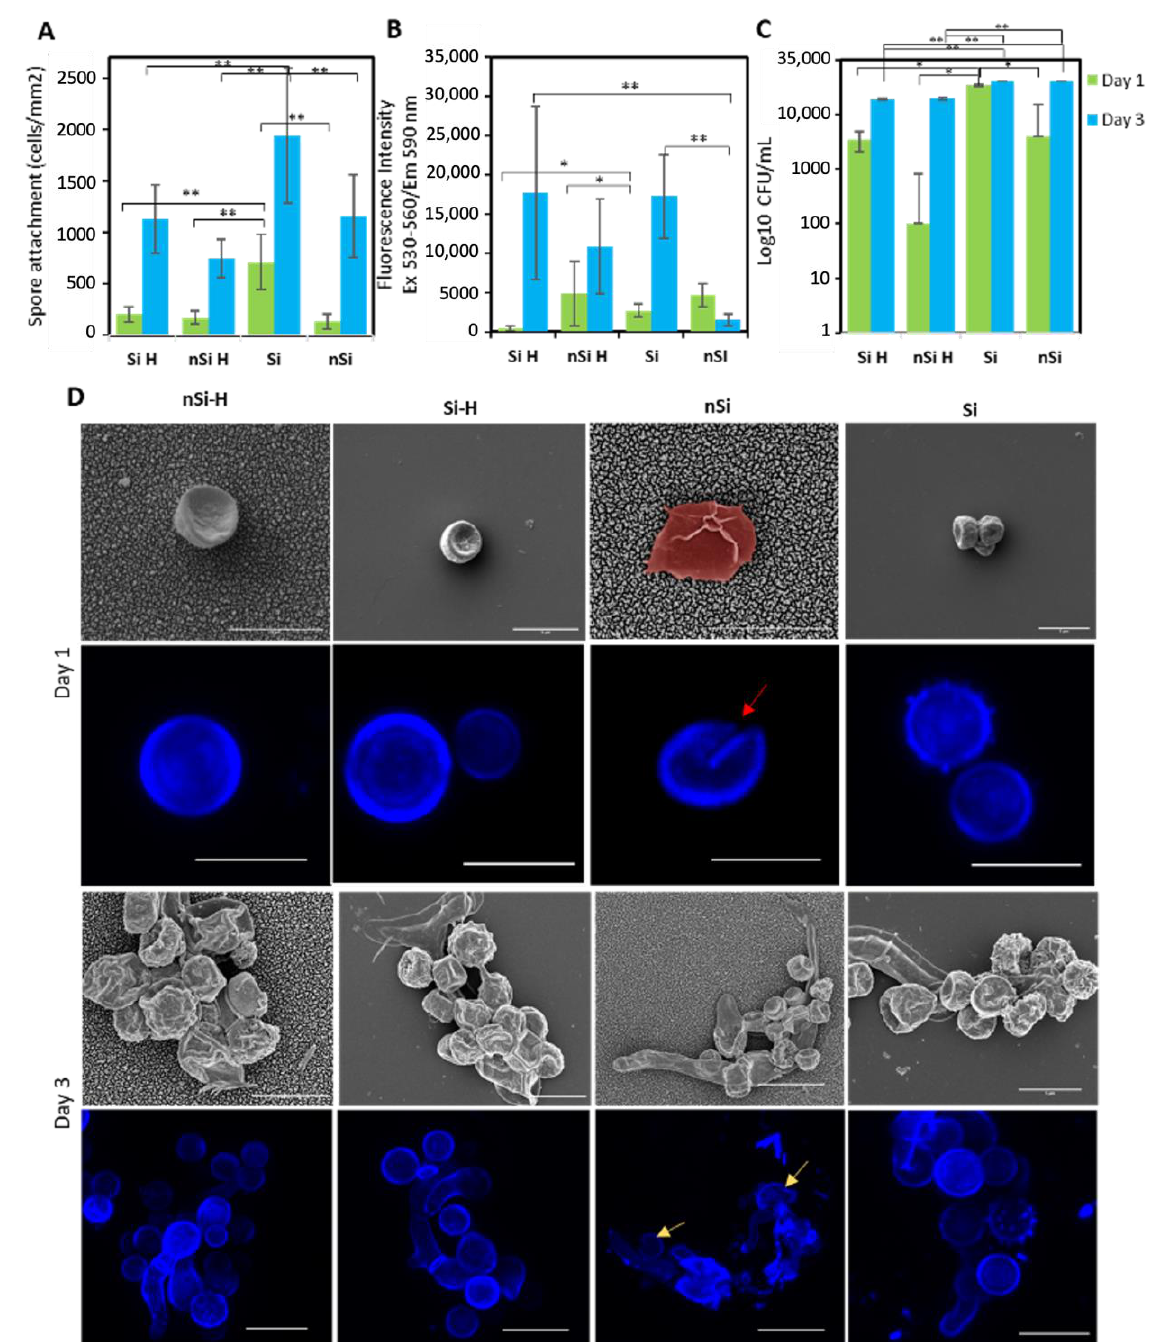
Figure 4. The density and morphology of A. brasiliensis spores when attached onto nano-Si and Si surfaces after a 24 and 72 h incubation period. ( A ) Attachment density of A. brasiliensis on substrata studied over a 1-day and 3-day incubation period. The number of attached spores was calculated using CLSM images ( n = 12). ( B ) Quantification of metabolic assay measured by Alamarblue TM assay of attached A. brasilensis spores on Si, Si-H, nSi and nSi-H surfaces after a 1- and 3-day incubation period. ( C ) The colony-forming units derived from attached spores on studies surfaces ( n = 3). Statistically significant differences were determined using a one-way ANOVA and Tukey’s multiple comparisons post hoc test (* p < 0.05; ** p < 0.01). ( D ) Representative SEM and CLSM micrographs showing the morphology of A. brasiliensis spores attached to nSi and Si surfaces. The cell wall of the fungal spores was stained with Calcofluor white (blue colour). The red and yellow arrows indicate the disruption of fungal spore coat. Scale bars on SEM and CLSM micrographs are 5 µm.